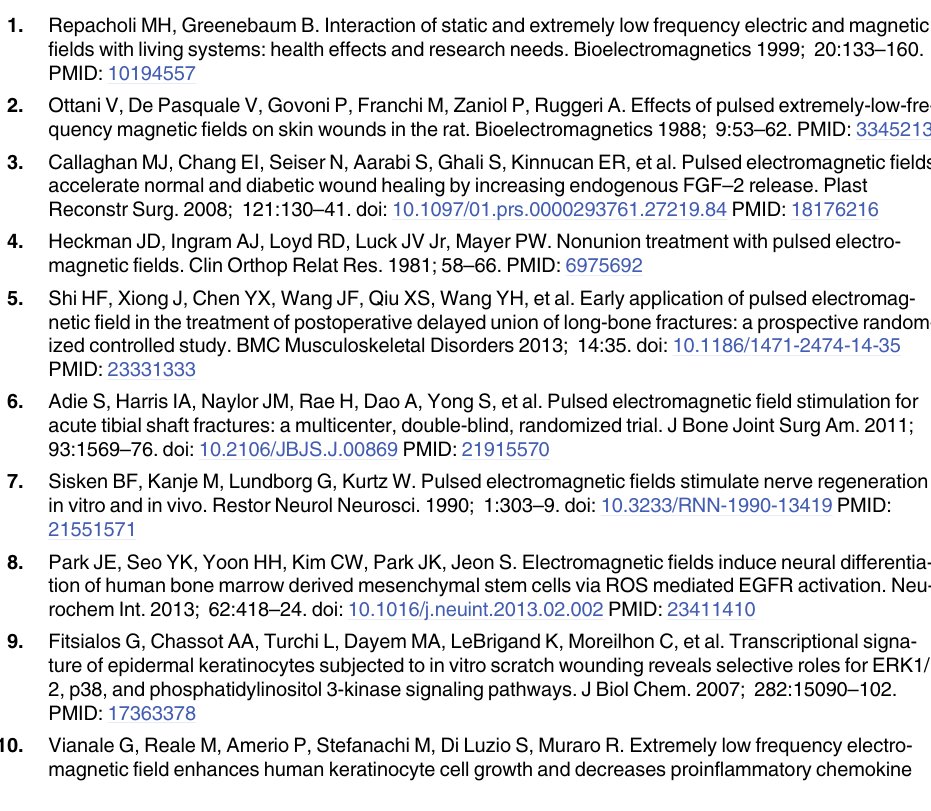
S1 Table. Human primers. Primers for selected genes were designed using GeneWorks soft- ware (IntelliGenetix, Inc., World Wide Corporation, U.S.A.). S2 Table. Genes involved in differentiation, proliferation and